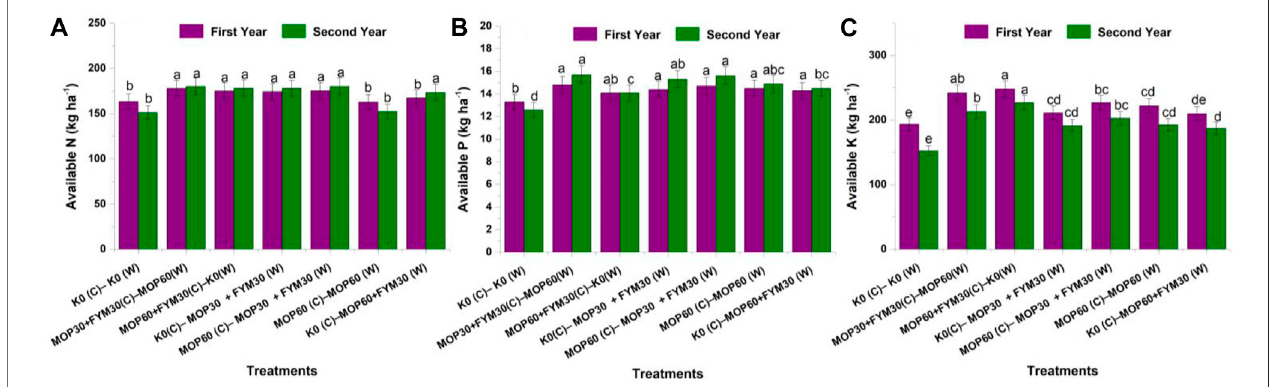
FIGURE 3 | Effect of integrated K application on nutrients availability in soil among treatments: available N (A) , available P (B) , and available K (C) .